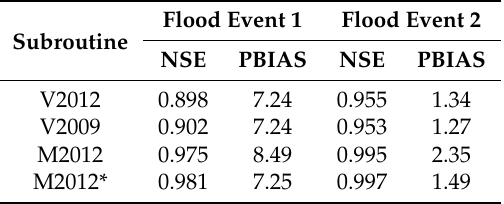
Table 2. Model performance statistics for flood event 1 (17 January 1990 to 17 April 1990, Figure 2a,b) and flood event 2 (18 December 1990 to 1 February 1991, Figure